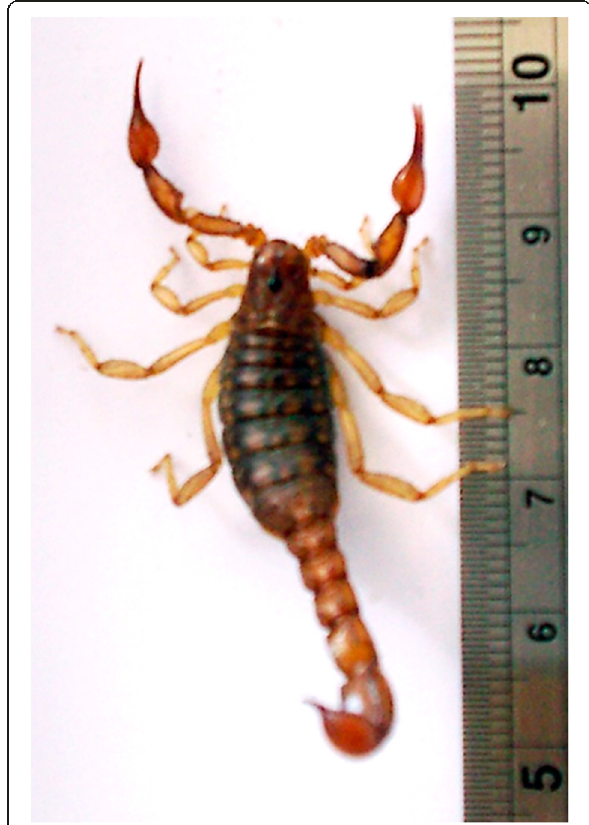
Fig. 1 Photo of a specimen of Hadruroides lunatus collected in Lima, Peru. This scorpion presents brown coloration and about 5 cm